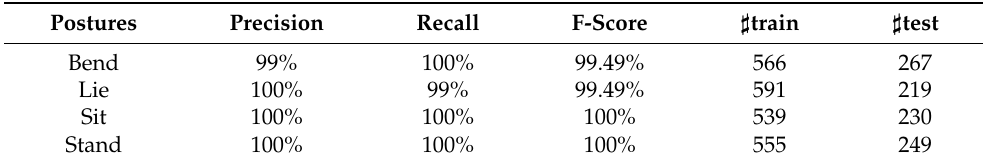
Table 5. Postures classification for dataset D1.